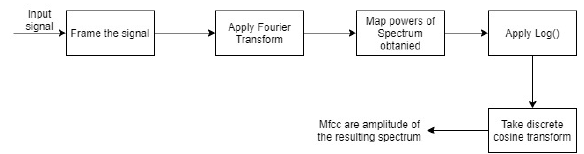
Figure 2. Flowchart of MFCC Feature Extraction process